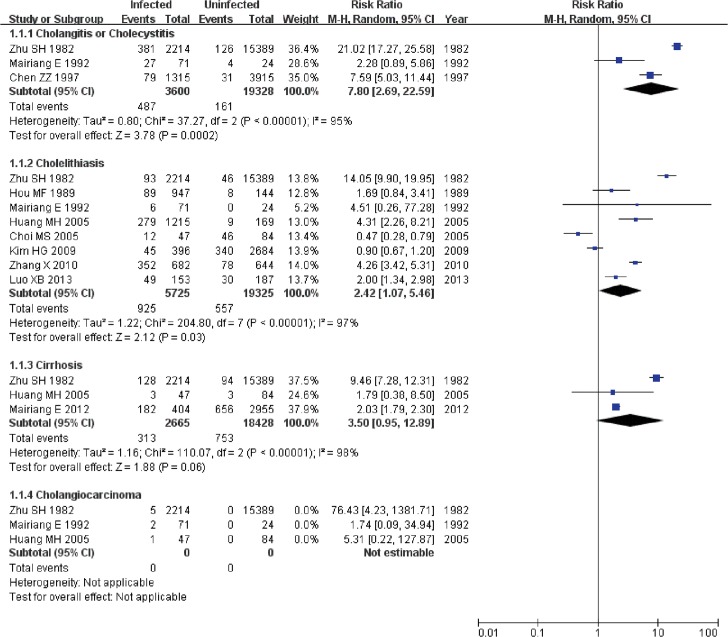
Forest plot of cohort studies on the relationship between liver fluke infection and various hepatobiliary pathological changes.